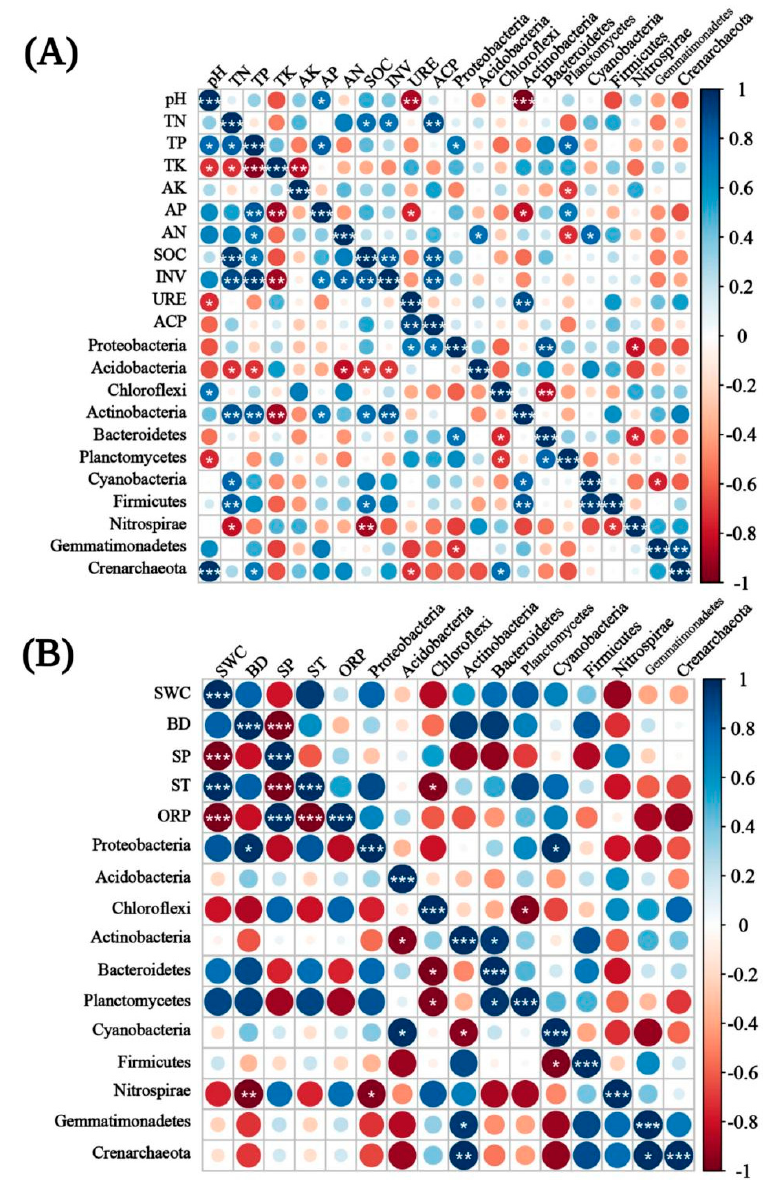
Figure 9. The relationships between soil properties, soil enzyme activities, and soil bacterial commu- nities under different emergence phases (T1 for early phase and T2 for late phase) within the Three Gorges Dam Reservoir, China. The Pearson correlation heat maps show the relationship strengths among soil chemical properties, soil enzyme activities, and bacterial community abundance in ( A ), and among soil physical properties, soil enzyme activities, and bacterial community abundance in ( B ). Circle size and color shade represent the correlation analysis value magnitude and direction. Blue and red represent positive and negative correlations. (The bottom left corner of the figure is T2, and the top right corner is T1). Significant at p < 0.001 (***) or p < 0.01 (**) or p < 0.05